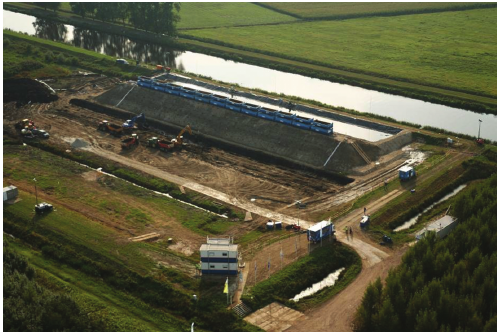
Figure 9: Aerial view of the stability test